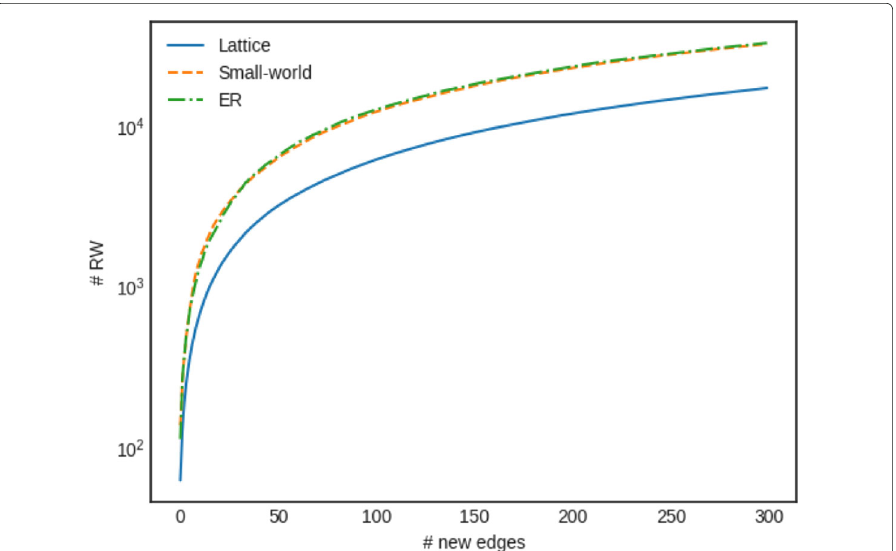
Fig. 5 Effect of network topology (the axis of # RW affected is in logarithmic scale). As more new edges are added, more random walks are affected. The effect is more stressed in the case of the Small-world and Erdos-Reyni networks, than the Lattice